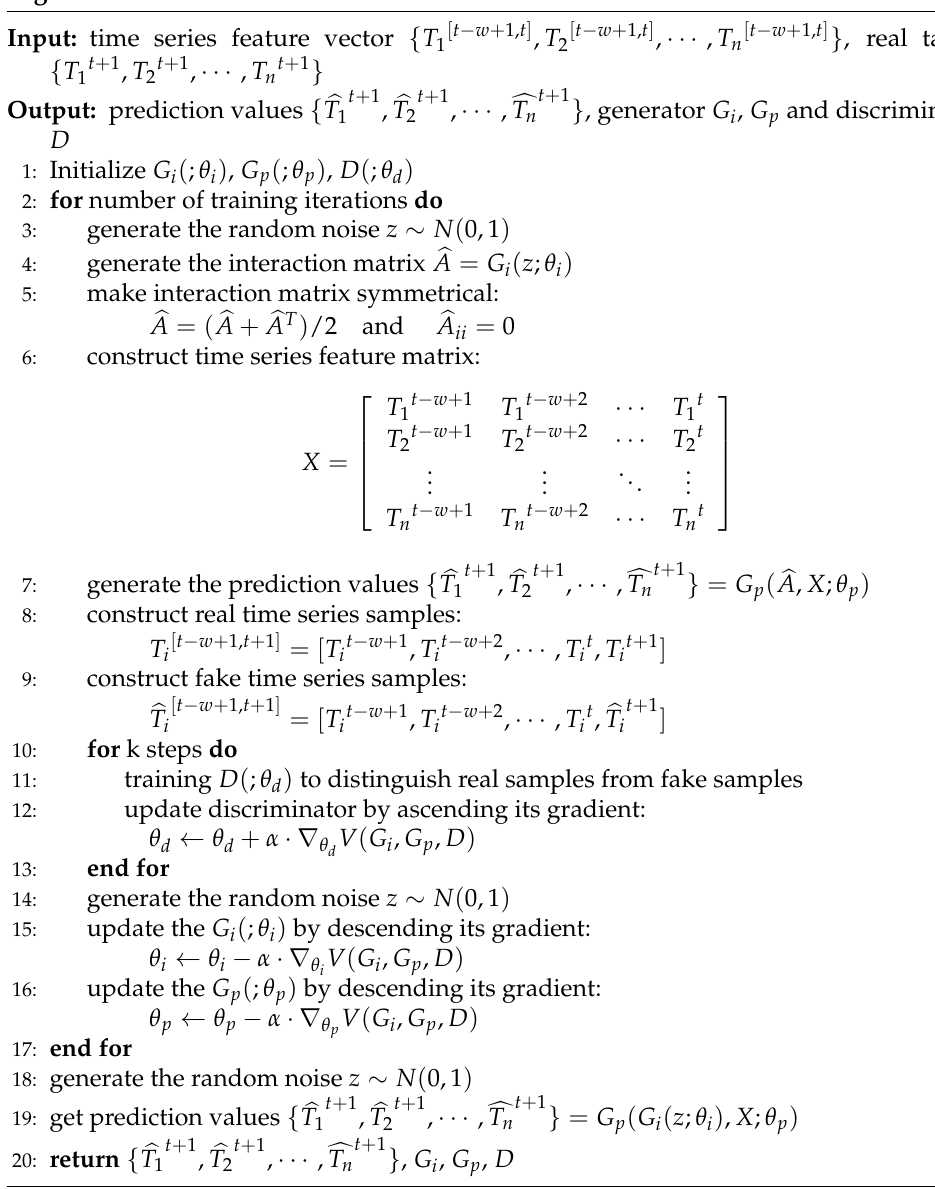
Algorithm 1 MTSGAN